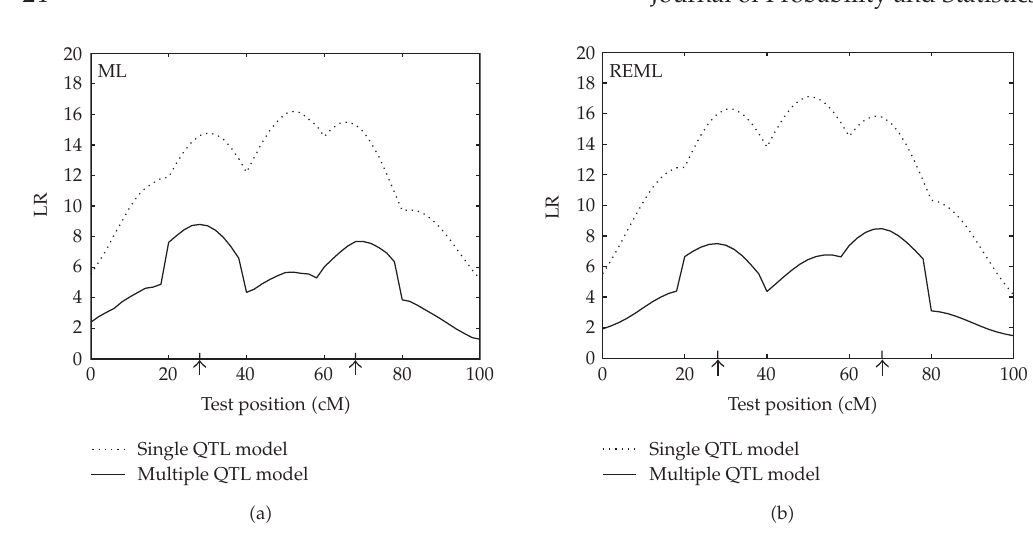
Figure 3: The LR profile plot for single QTL and multiple QTL analyses. The true QTL positions are simulated at 28 cm and 68 cm (cid:2) see the arrow sign (cid:3) . The dotted curve and the solid curve represent the LR profiles by single QTL and multiple QTL analyses, respectively. The left and right figures correspond to the LR profiles generated using the ML and REML methods,